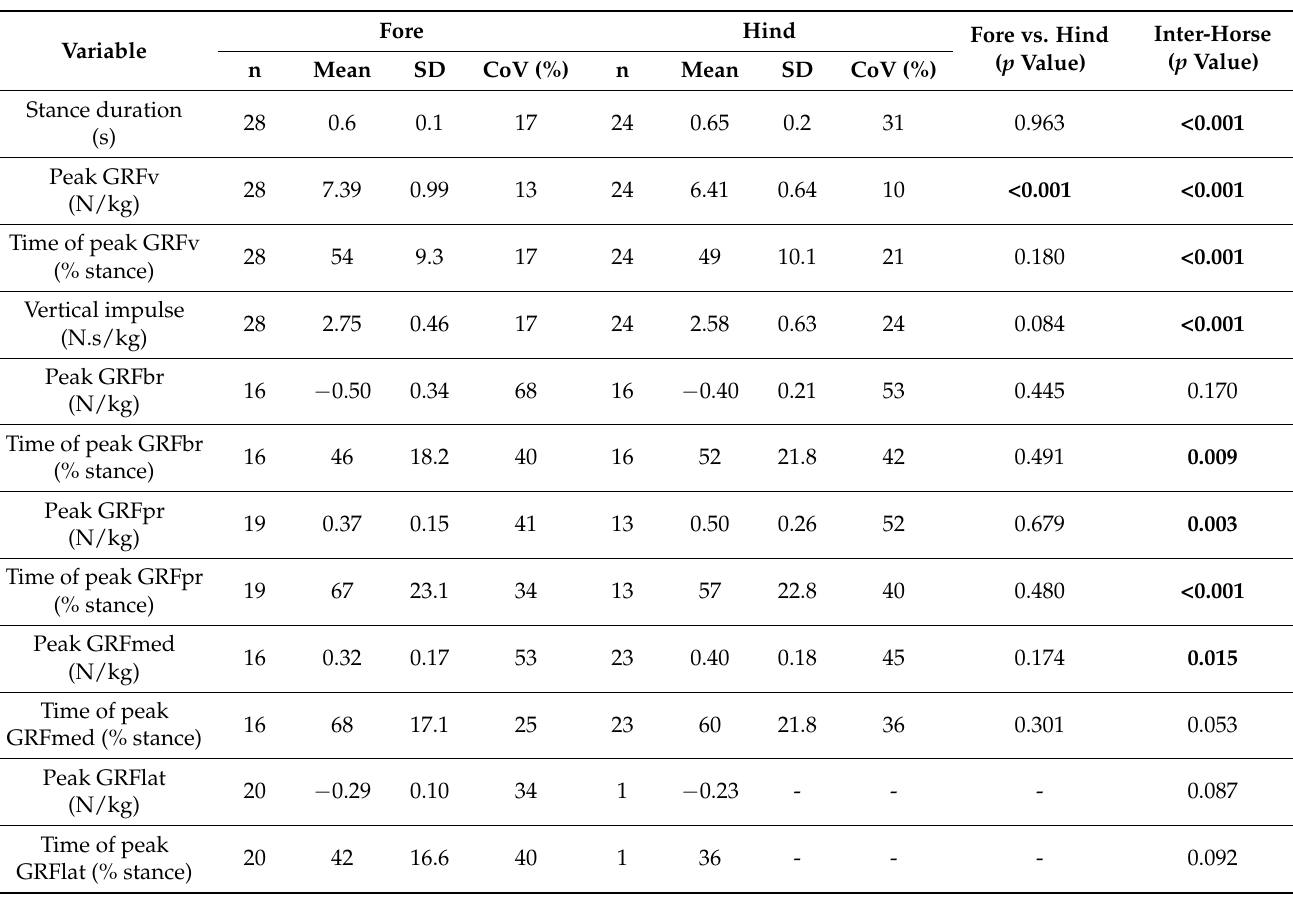
Table 1. Temporal and ground reaction force variables for a group of horses (N = 7) performing the piaffe. Comparisons between the fore- vs. hindlimbs and between individual horses were made using ANOVA for normally- distributed variables (peakGRFv, time of peak GRFv, peakGRFpr, time of peak GRFpr, peakGRFmed, peak GRFlat) and the Mann–Whitney U test (fore vs. hind) and Kruskall–Wallis test (between horses) for all other non-normally distributed variables. Significant differences ( p < 0.05) are bolded. CoV: coefficient of variation, n: number of stance phases. Vertical GRF (GRFv) is positive upwards; braking GRF (GRFbr), propulsive GRF (GRFpr), positive cranially; and medial GRF (GRFmed), lateral GRF (GRFlat), positive medially. Note: Fore vs. hind comparison was omitted from analysis for peak GRFlat, due to the lack of data on the